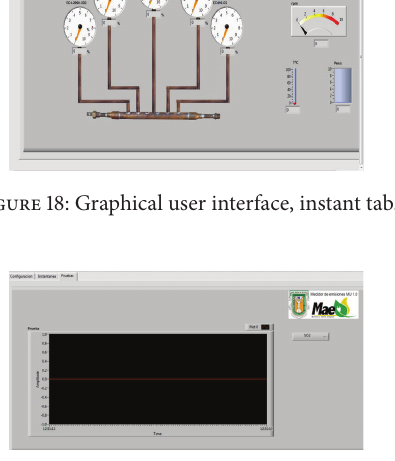
Figure 19: Graphical user interface, testing